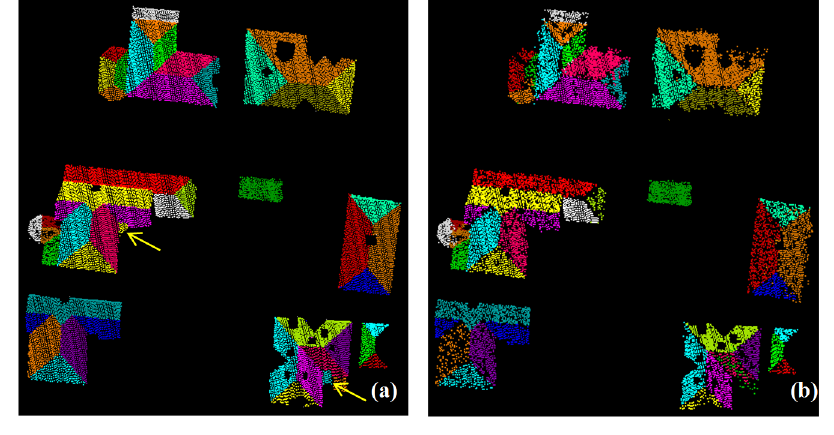
Figure 9. Validation results for house roof segments: ( a ) manual segmentation ( b ) automatic segmentation.